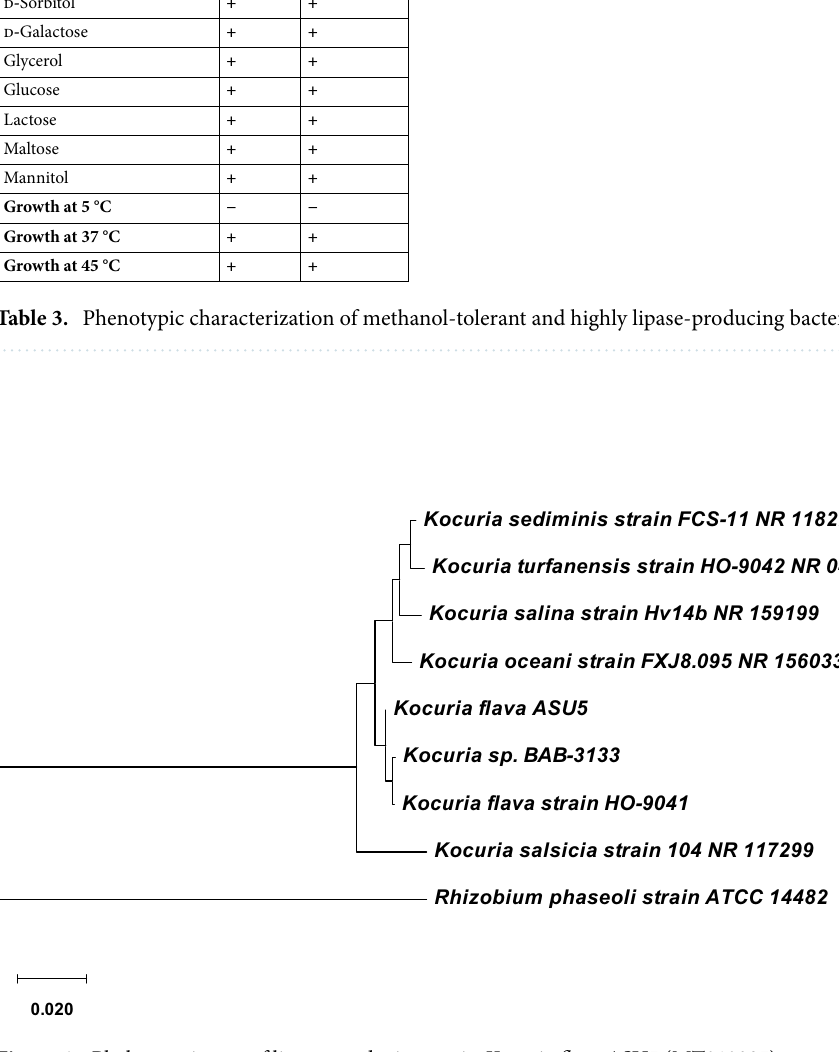
Figure 4. Phylogenetic tree of lipase-producing strain Kocuria flava ASU5